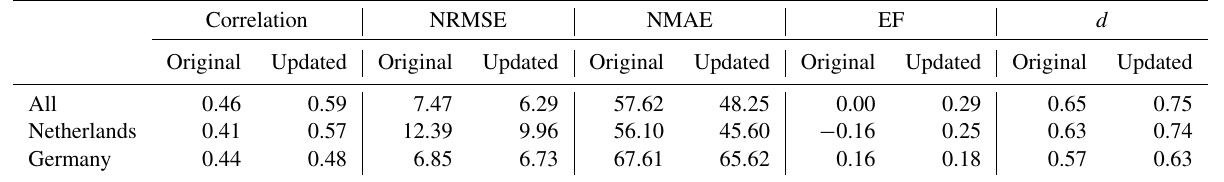
Table 3. Performance assessment of the original and the updated model by comparing NH 3 weekly (monthly) surface concentration. Corre- lation, NRMSE, NMAE, EF and d are calculated using in situ measurements and modeled results.